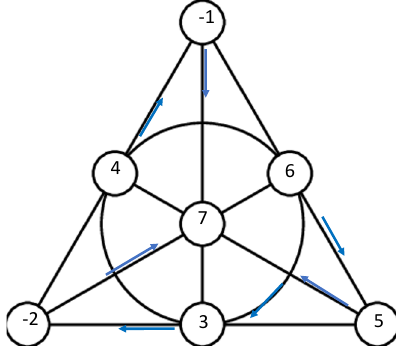
Figure 23 . An oriented Fano plane corresponding to figure 1 in [21]. The difference with a Fano plane in [29], shown in figure 3 here, includes a relabeling of some points as well as opposite direction of 4 arrows. But these two Fano planes are for the same octonion multiplication table in figure 2.